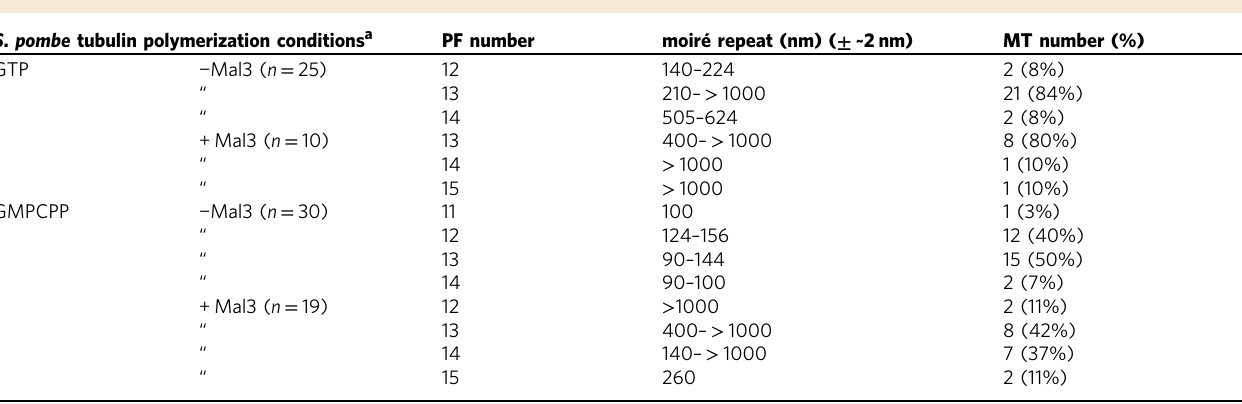
Table 1 Effect of polymerization conditions on Sp_tub MT